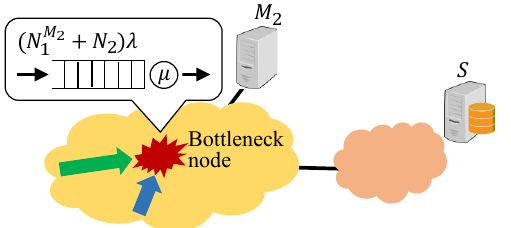
Figure 2. M/M/1 queueing model for bottleneck node in a MEC